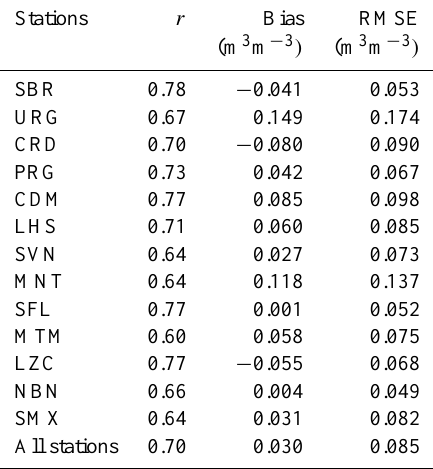
Main statistical scores for the comparison between modelled SSM from the SIM model and in situ SSM (5cm) for the twelve stations of the SMOSMANIA network and for the SMOSREX site over a two-year period